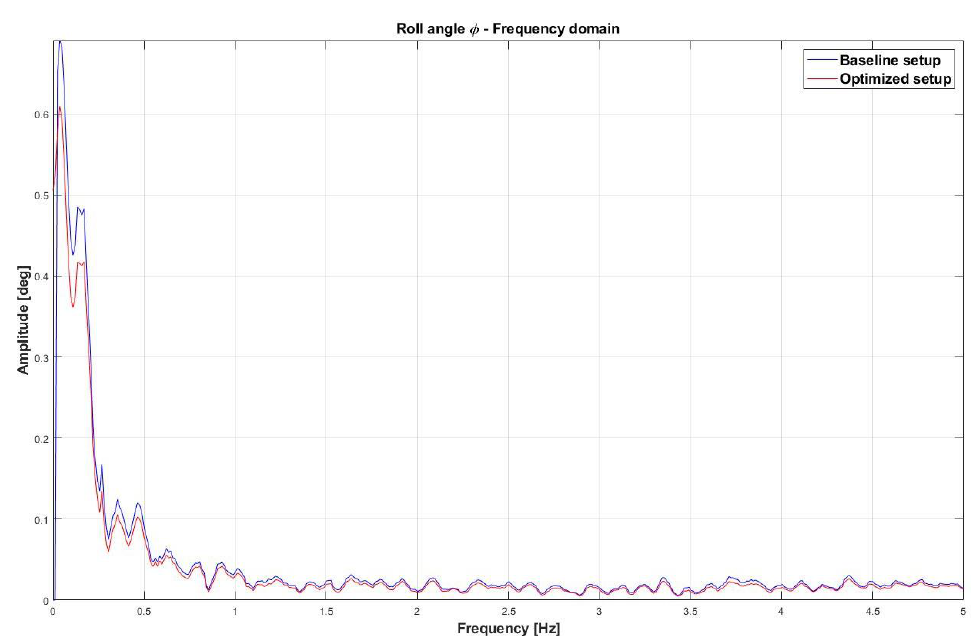
Figure 21. Comparison between the baseline provided setup and improved setup for the roll angle trend in the frequency domain.